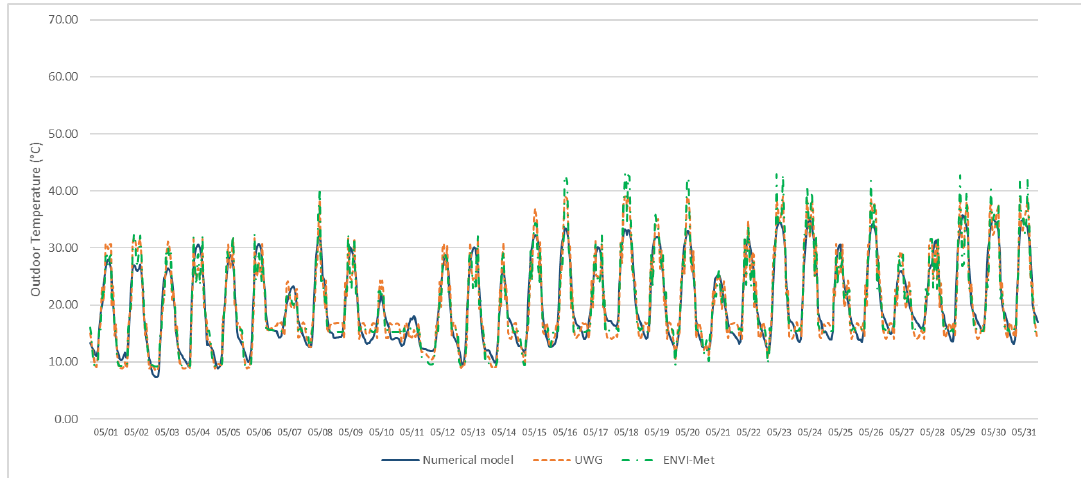
Figure 10. Hourly outdoor temperatures for May on Barcelona comparing the numerical model developed here, UWG, and ENVI-Met.